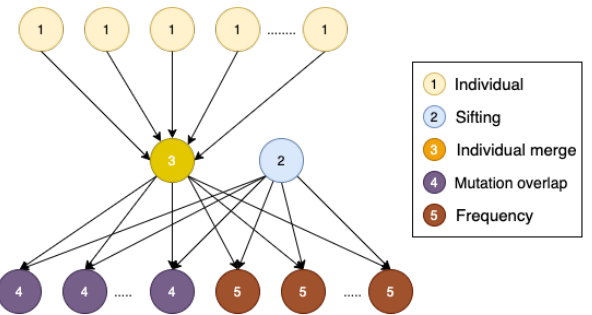
Figure 14. A Simple Bioinformatics